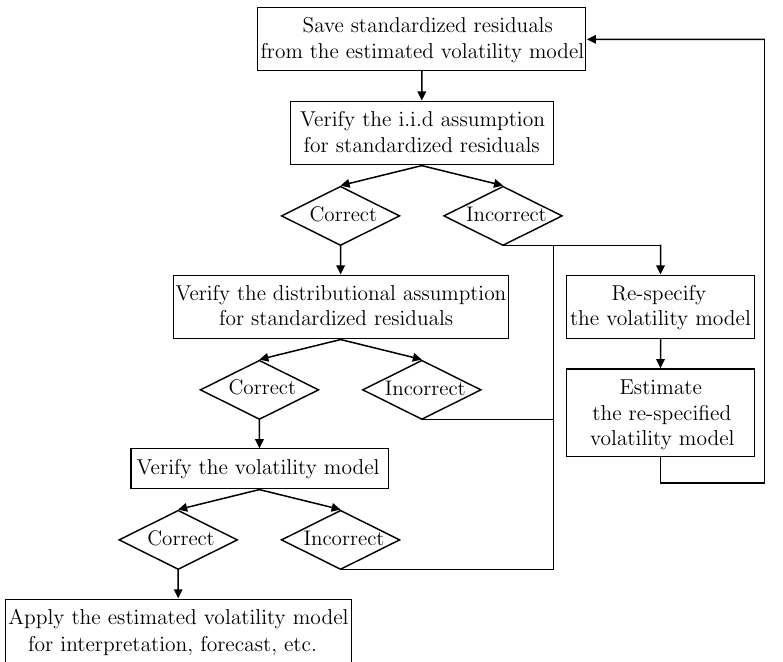
Figure 5. Model selection scheme. Source: Author’s illustration.